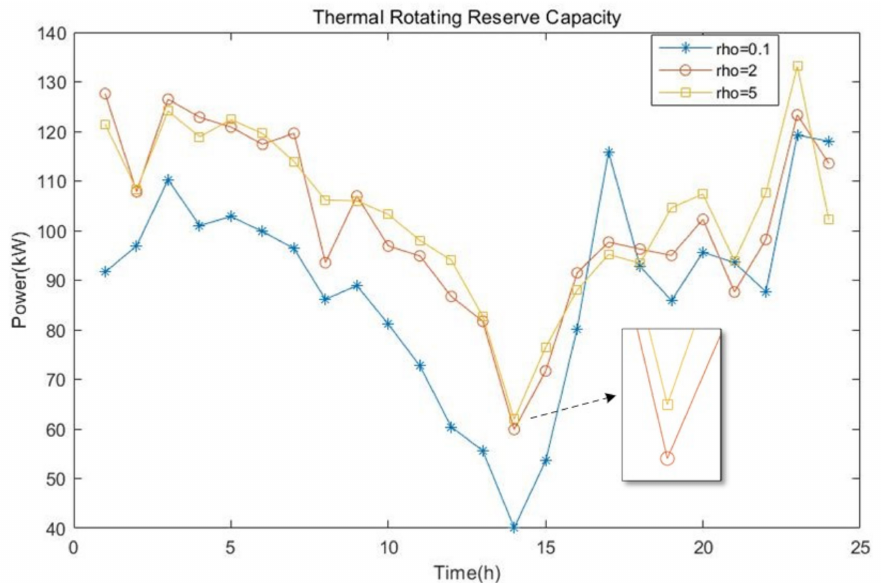
Figure 10. Influence of Risk Preference Coefficient on Thermal Rotating Reserve Capacity.